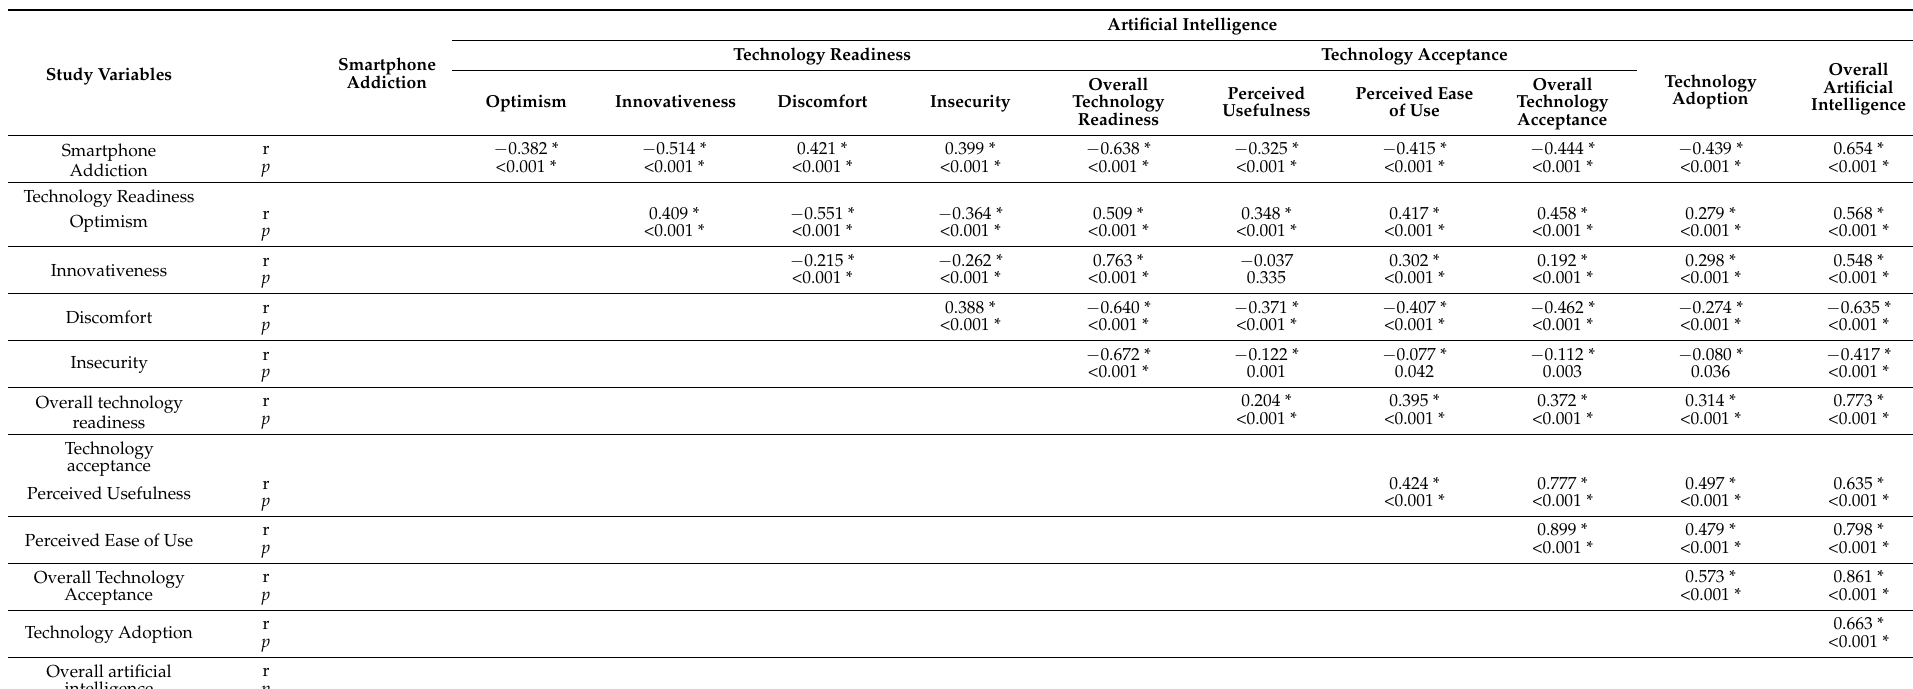
Table 3. Correlation matrix between the study variables ( n =